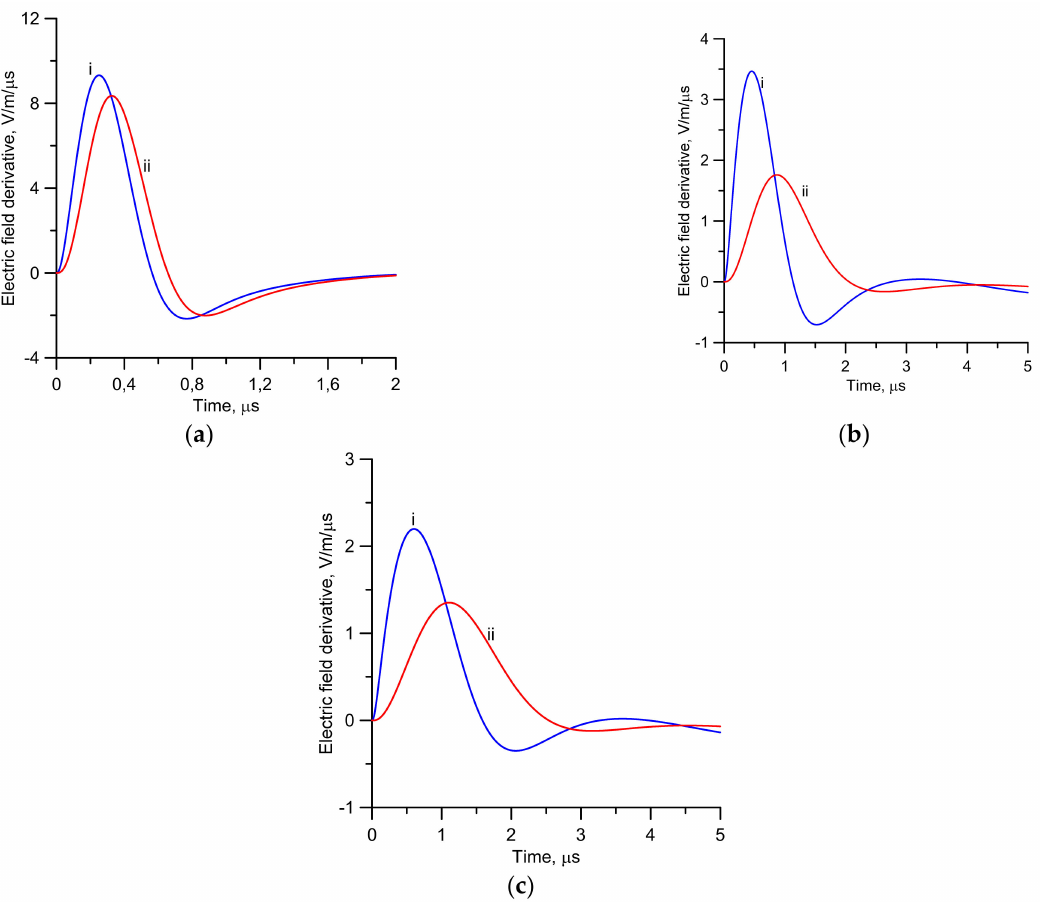
Figure 16. The electric field derivative after propagating ( a ) 2 km over σ = 0.001 S/m, ( b ) 1 km over σ = 0.0001 S/m, and ( c ) 2 km over σ = 0.0001 S/m. Curve (i) corresponds to the results obtained if the source fields are identical to that of striking sea water and curve (ii) corresponds to the results obtained if the source fields are modified by the ground conductivity at the strike